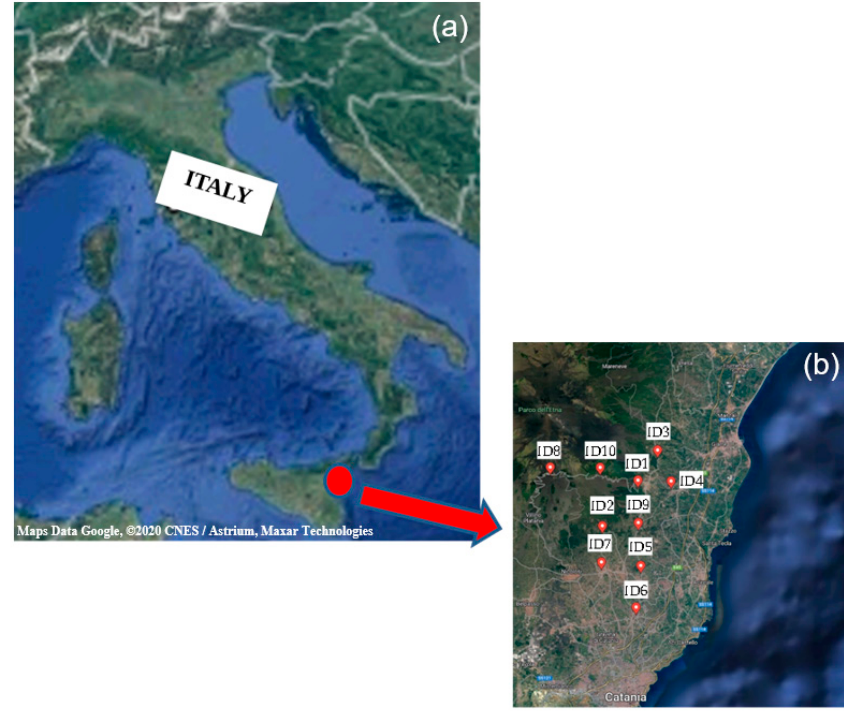
Figure 1. The map of the sampling area ( a ), with the site IDs (1–10) indicated ( b ).